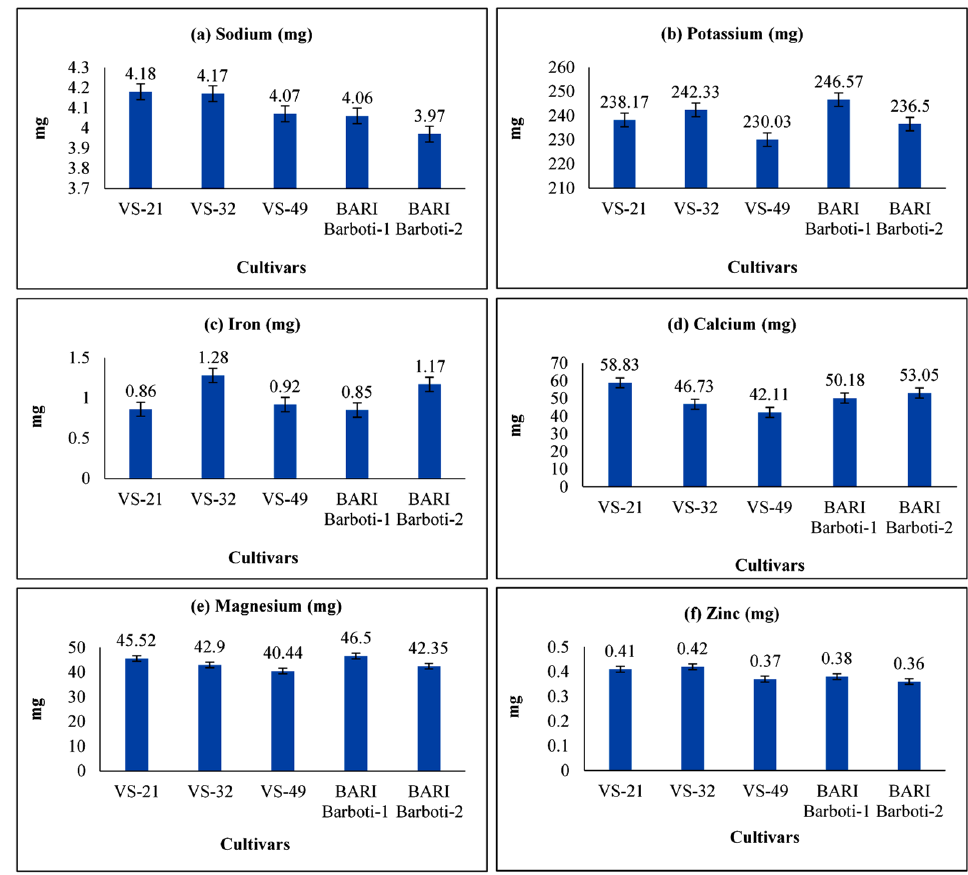
Figure 6. ( a ) sodium, ( b ) potassium, ( c ) iron, ( d ) calcium, ( e ) magnesium and ( f ) zinc content of five yard-long bean cultivars commonly grown in Bangladesh [The parameters were estimated from 100 g dry matter].